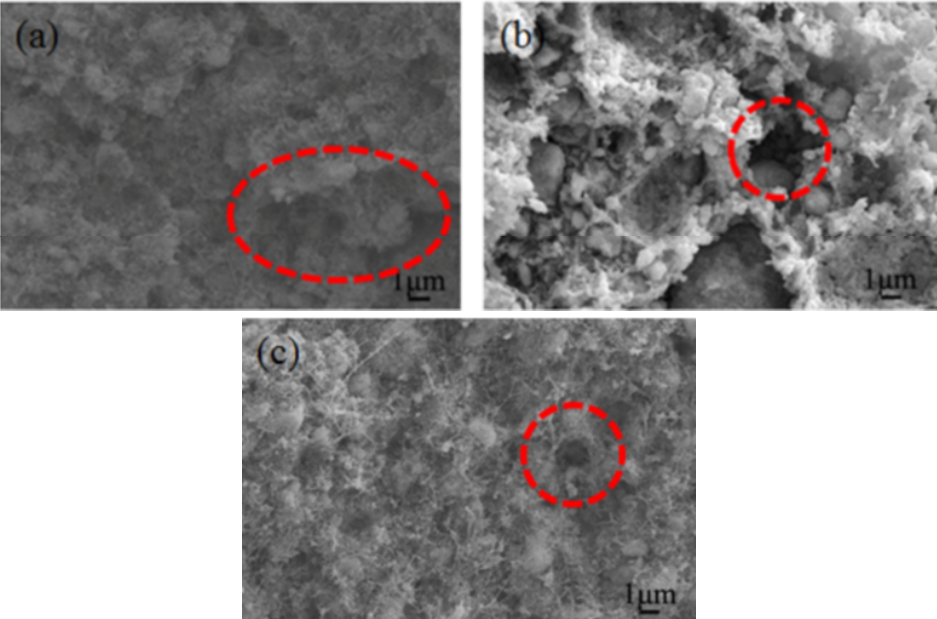
Fig. 6 Scanning electron micrographs of the parts using various thermal polymers after leaching in kerosene at 60 ℃ for 20 h: (a) EVA and HDPE (E/H), (b) LDPE (L), (c) LDPE and HDPE